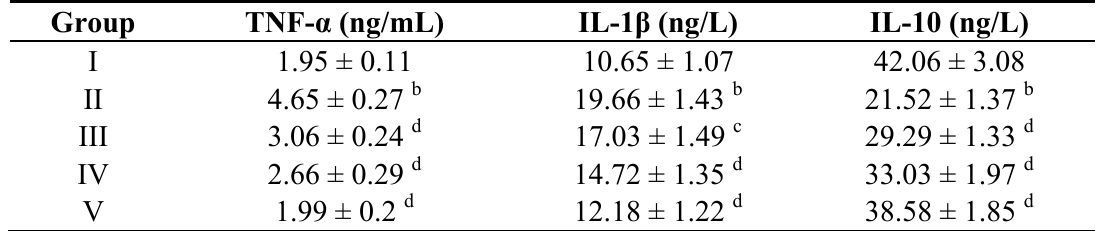
Table 1. Effects of sevoflurane postconditioning on serum TNF- α , IL-10 and IL-1 β